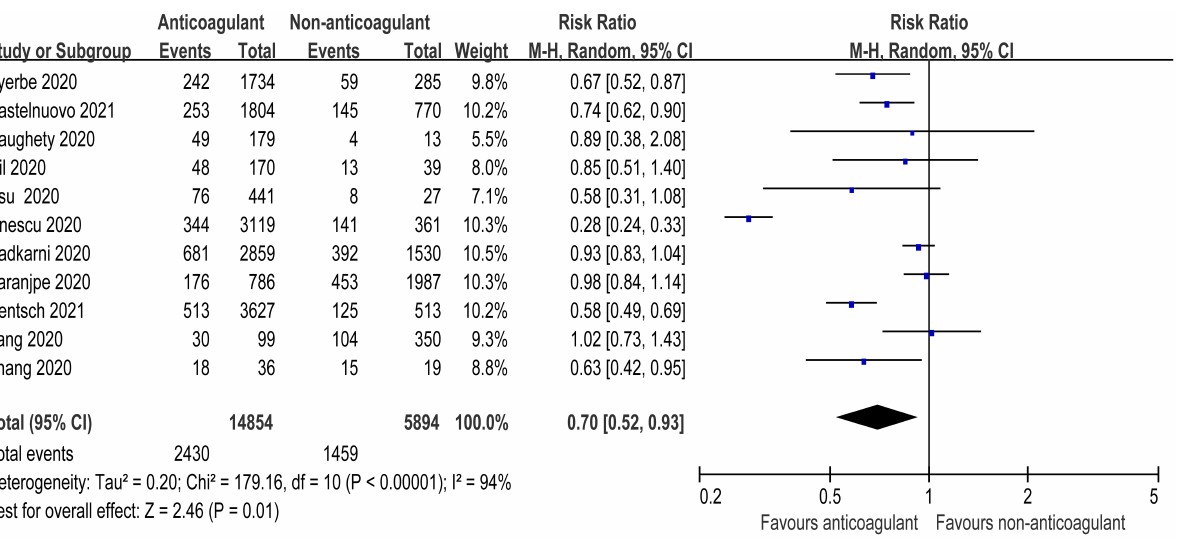
FIGURE 2 | Forest plot of the effect of anticoagulants on risk of mortality in hospitalized COVID-19 patients.